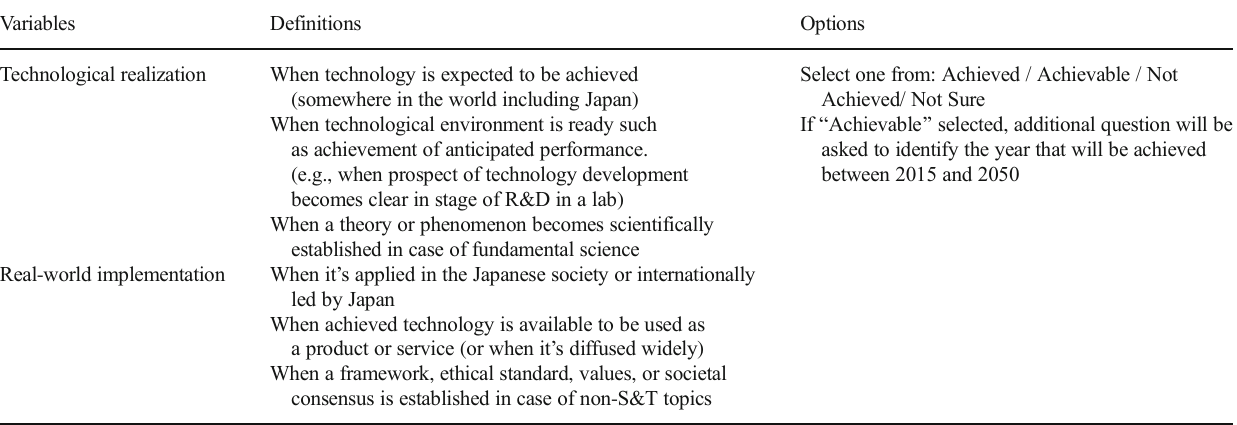
Timing of realization and implementation Variables Definitions Technological